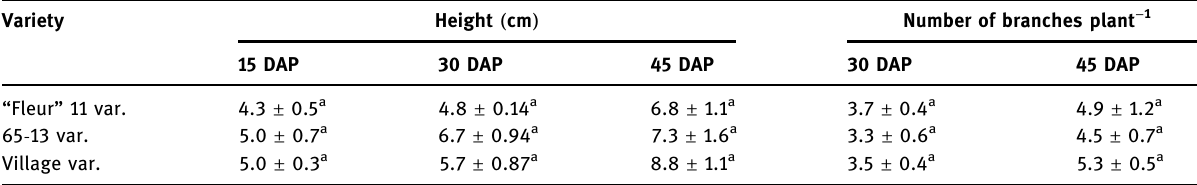
Table 3: Plant height and number of branches before phyto - extract applications